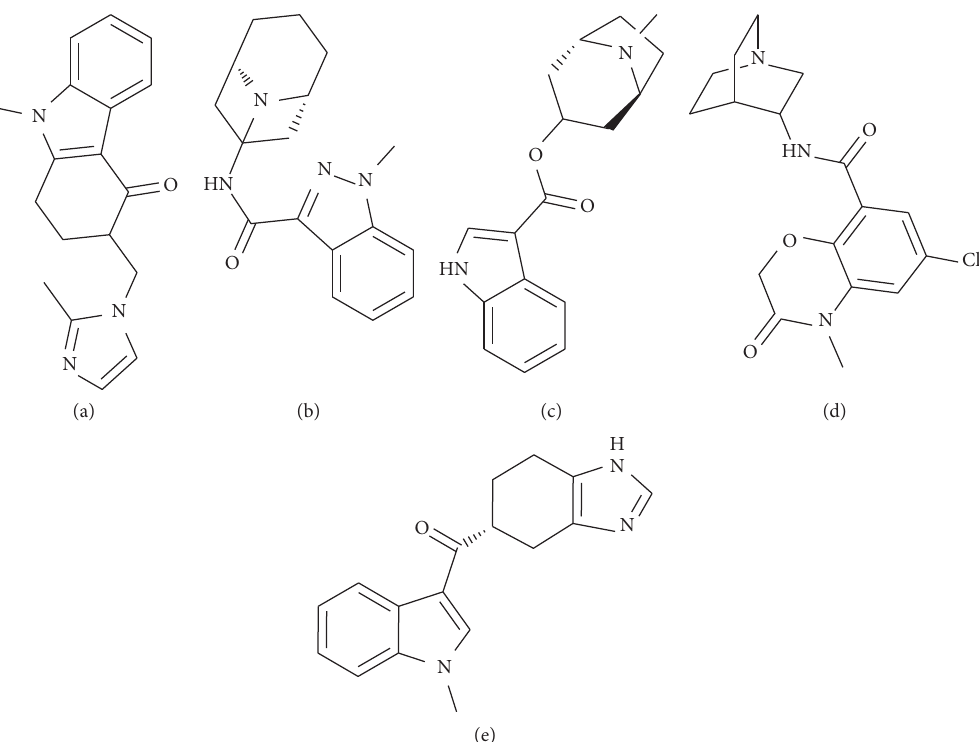
Figure 1: Chemical structure of ODT (a), GNT (b), TPT (c), AZT (d), and RMT